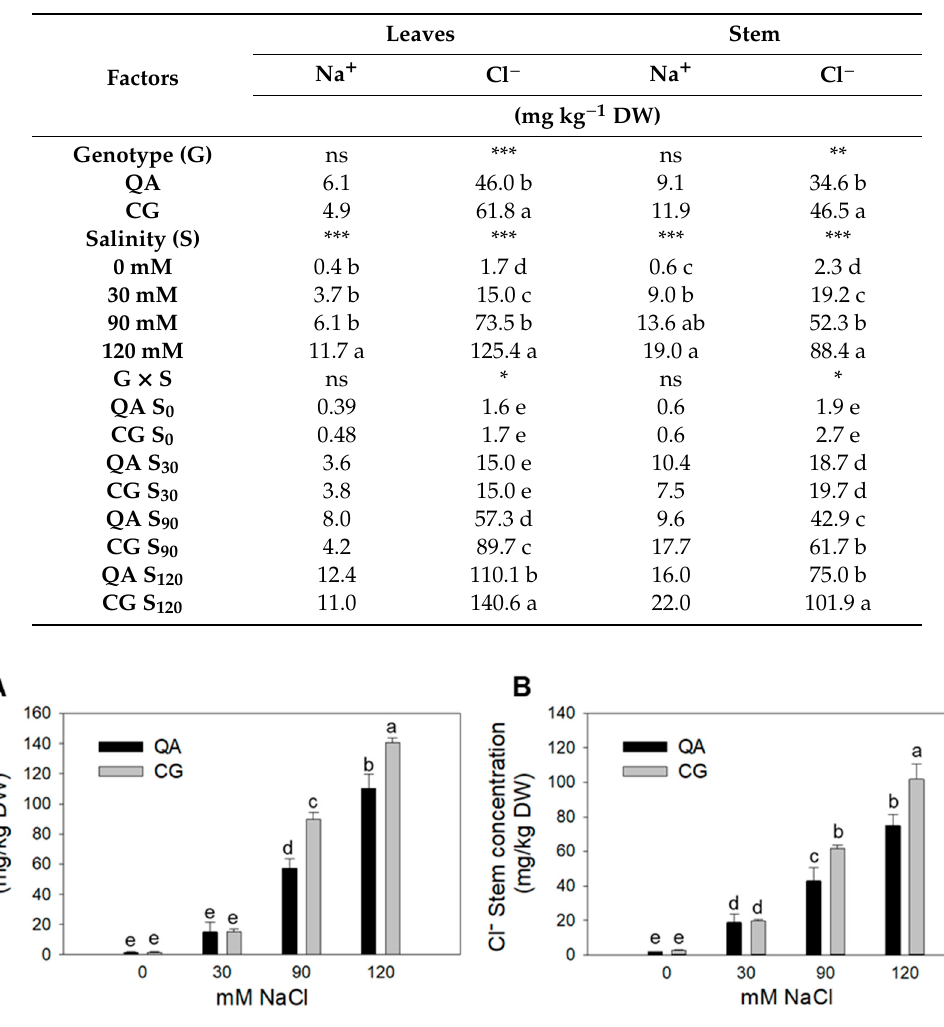
Table 4. E ff ect of genotype, salinity and their interaction on Na + and Cl − content in leaves and stems of the commercial cultivar (QA) and the landrace (CG) grown at control (0 mM), low salinity (30 mM), moderate salinity (90 mM) and high salinity (120 mM) at DAT 168. ns, *, **, *** indicate not significant or significant di ff erences at p < 0.05, p < 0.01 and p < 0.001 according to ANOVA, respectively. In each column, for each factor, means with the same letter are not significantly di ff erent according to Duncan’s post hoc analysis.